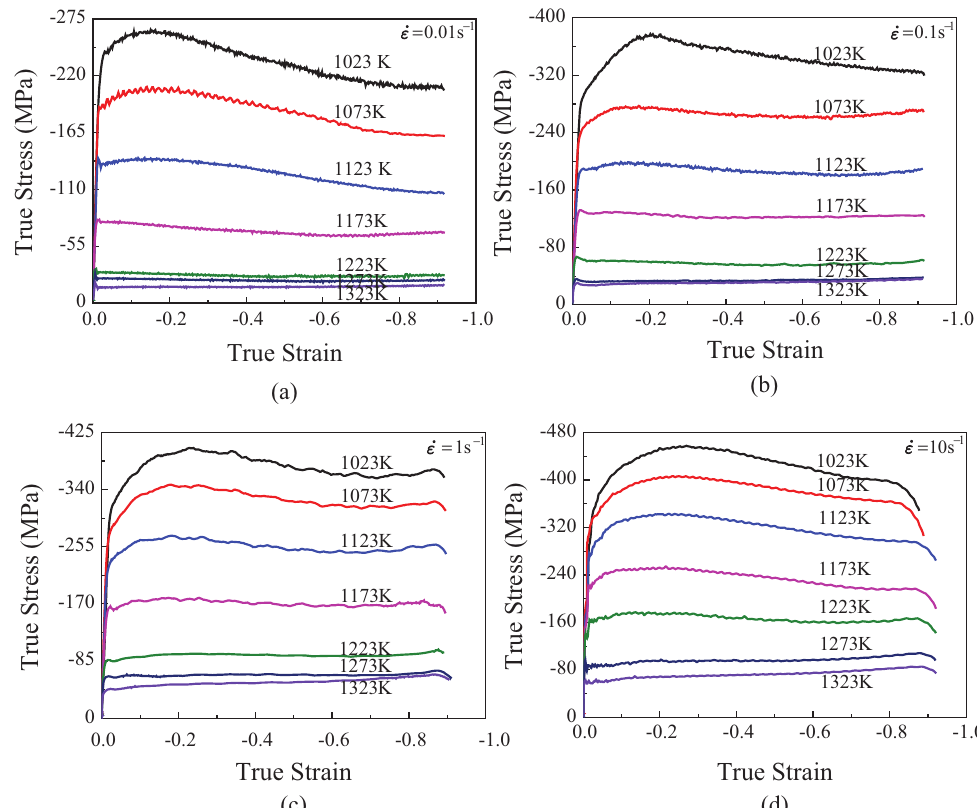
Figure 1: The true stress-strain curves of Ti-6Al-4V alloy under the different deformation temperatures with strain rates (a) 0.01 s − 1 , (b) 0.1 s − 1 , (c) 1 s − 1 , (d) 10 s − 1